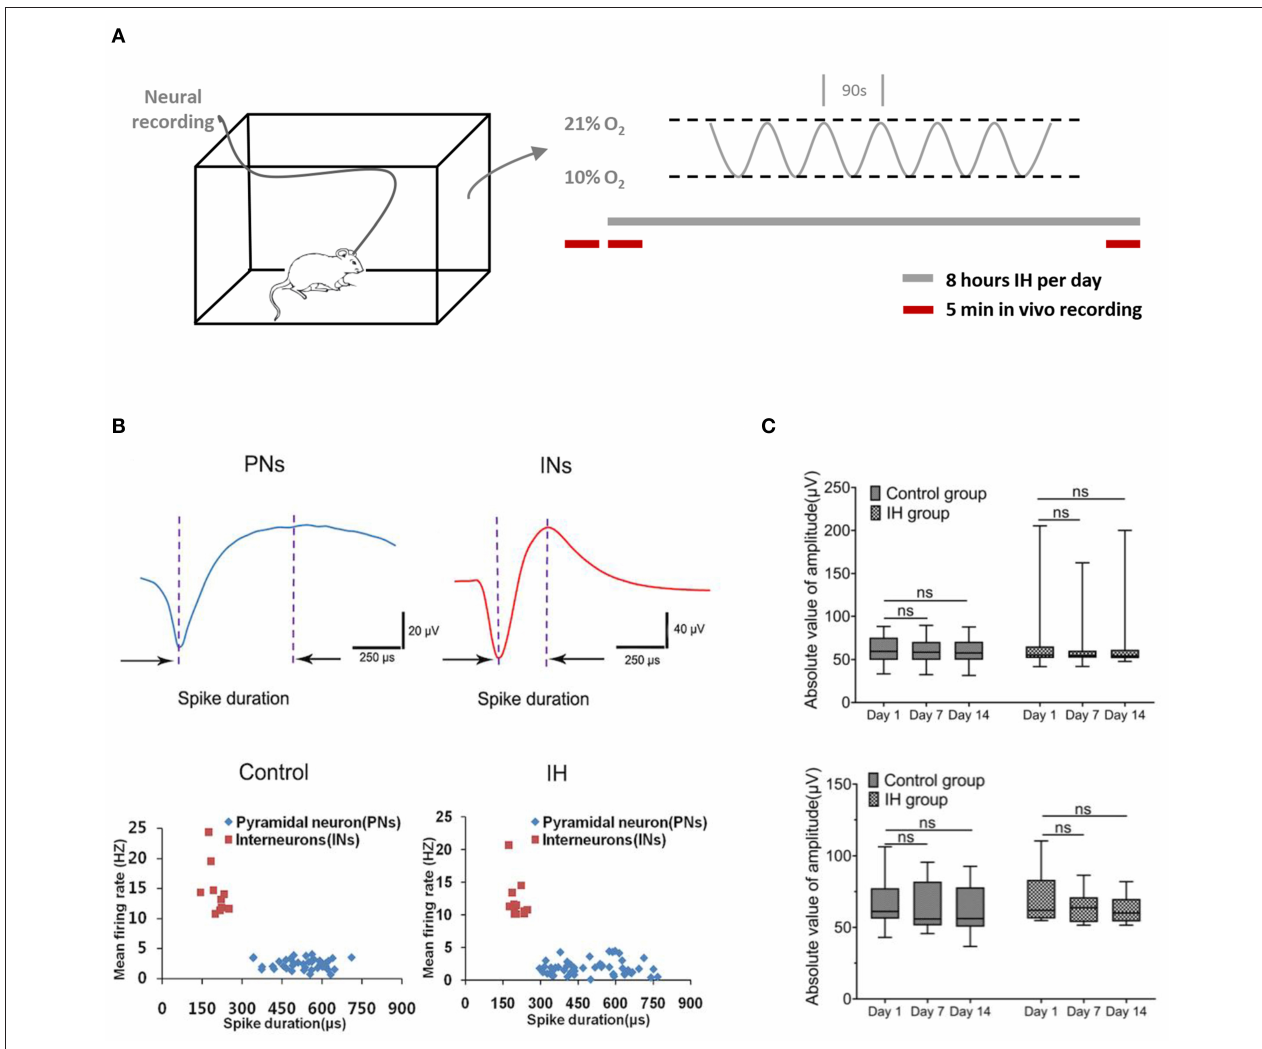
FIGURE 1 | Characterization of neural activities in hippocampl CA1 sub-field during prolonged in vivo recordings. (A) (Left) Ventilated cages that mimic typical housing conditions were used to expose the experimental rats to intermittent hypoxia paradigms while recording the neural activities from the hippocampus. (Right) The intermittent hypoxia pattern consists of cyclic oscillations of O2 between 21 and 10% within 90 s during the 8-h daylight. Five-min recording sessions was conducted which were immediately before, at the beginning and also at the end of the daily 8-hr hypoxia treatment during the entire 2-weeks study. (B) Recorded neurons were classified into putative pyramidal neurons (PNs) and putative interneurons (INs) based on their electrophysiological properties. (Top) Two typical single-units representing PN (blue) and IN (red) respectively. (Bottom) Scatter plots depicting the distribution of mean firing rate vs. spike width of all PNs and INs recorded from the CA1 region of hippocampus in control and intermittent hypoxia (IH) group. Compared with putative pyramidal neurons, putative interneurons exhibited spikes with shorter spike width but higher firing rates. (C) Repeated measure ANOVA revealed that the amplitudes of putative pyramidal neurons (top) and putative interneurons (bottom) during the 2 weeks showed no significant